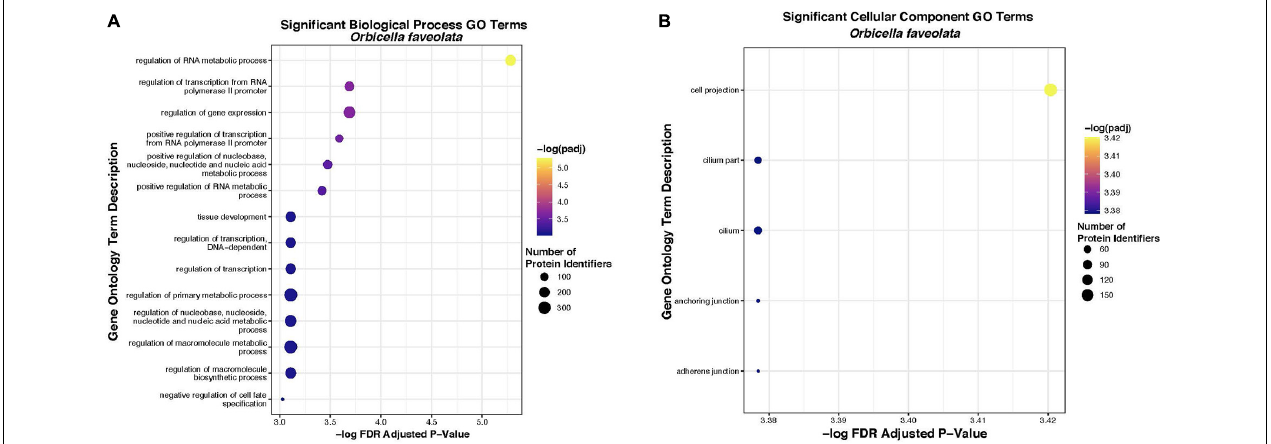
FIGURE 6 | Significantly overrepresented biological process (A) and cellular component (B) gene ontology terms in O. faveolata . Significant enrichment was tested for a list of 2005 uniquely annotated differentially expressed genes between control and disease exposed O. faveolata fragments. Color indicates FDR p adj from hypergeometric overrepresentation test (yellow = most significant). Size of dot indicates number of uniquely annotated genes that were identified and mapped to gene ontology terms by protein identifier, in each significant GO category.